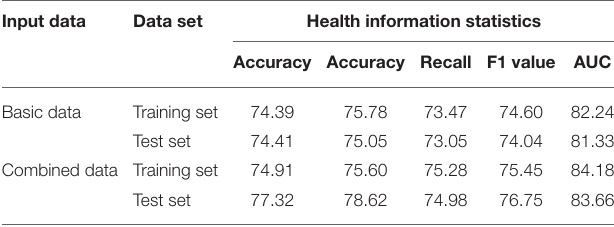
TABLE 4 | Logistic regression model evaluation of basic data and combined